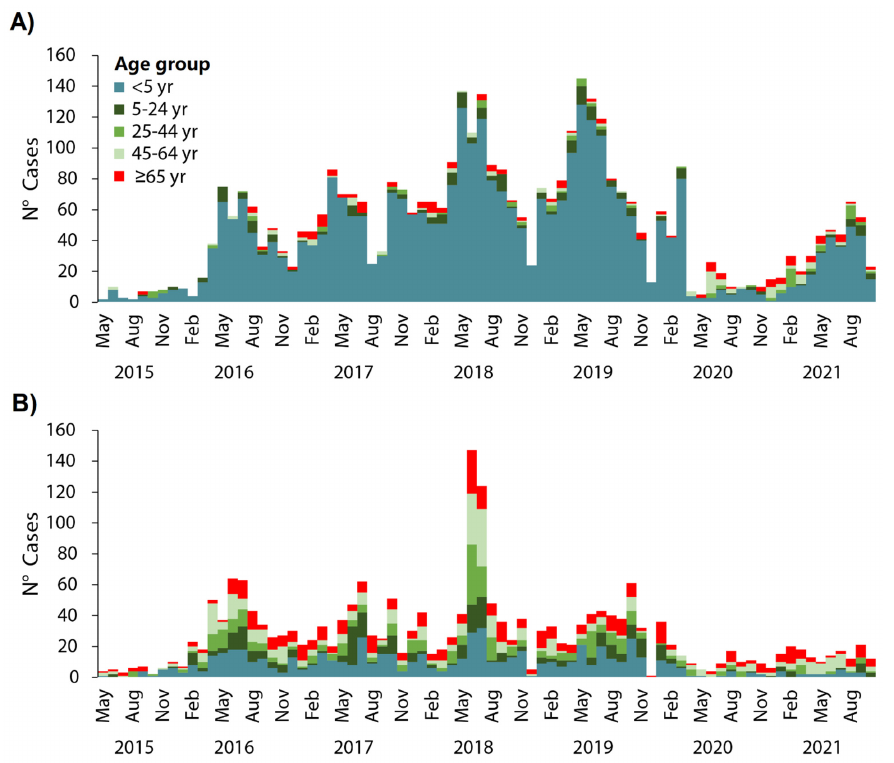
Figure 1. Monthly hospitalizations from the RSV and the influenza virus in Peru, seasons from 2015 to 2021.